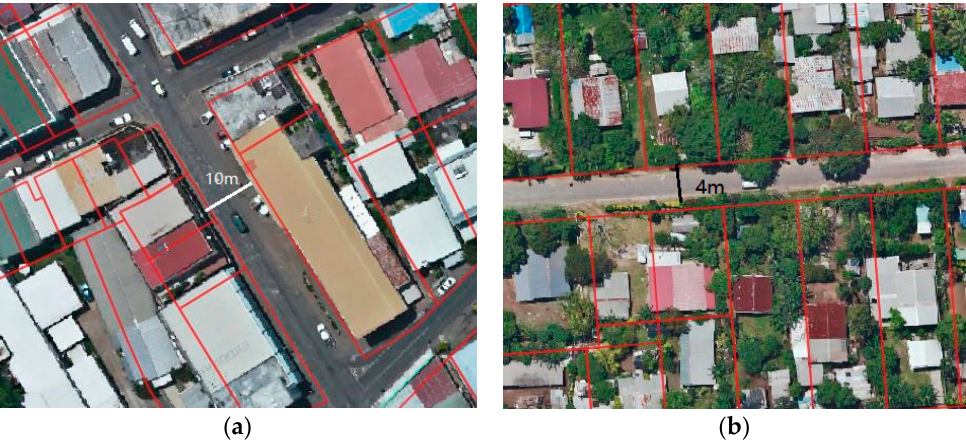
Figure 4. The illustration of roads with the cadastral boundaries in ( a ) dense urban area and ( b ) suburban area.